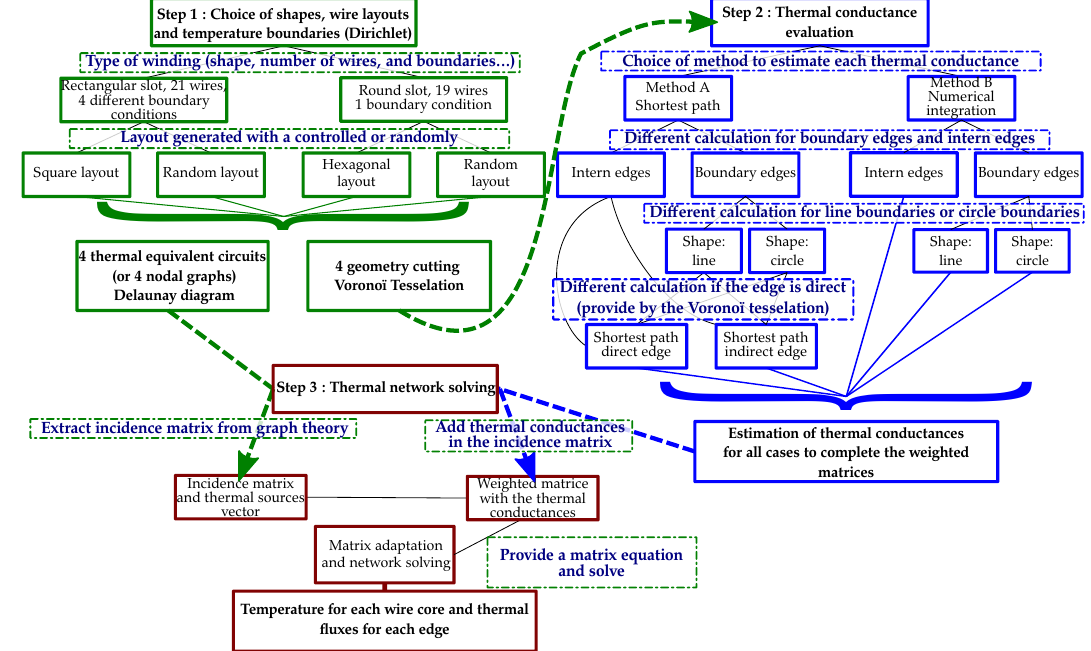
Figure 1. Flow-chart to define different steps of the thermal model with its different